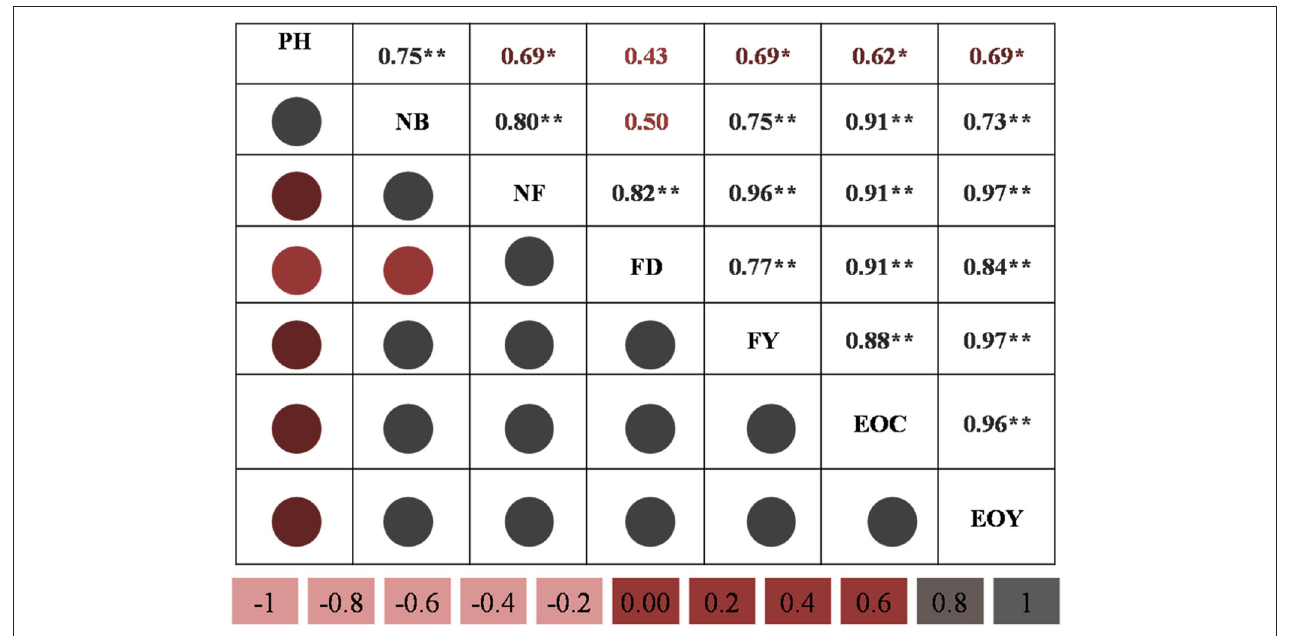
FIGURE 5 | Correlation analysis of growth and yield parameters. PH, plant height; NB, number of branches; NF, number of flowers; FD, flower diameter (in cm); FY, dry flower yield (in t ha − 1 ); EOC, essential oil content (in %); EOY: essential oil yield. The mean values of the 2-year pooled data of the corresponding treatments are used; * and ** indicate that the corresponding values are significant at p = 0.05 and p = 0.01,